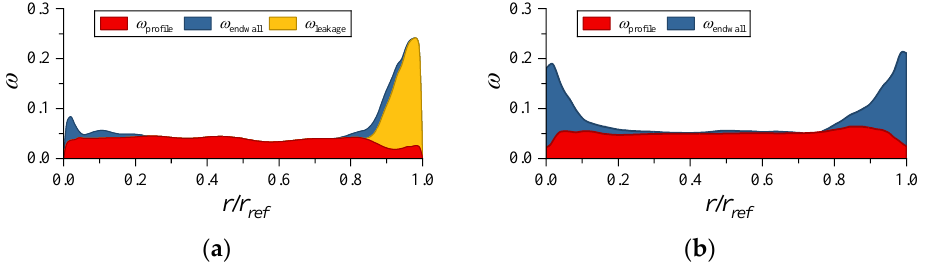
Figure 19. Decomposition of the total pressure loss along the radial direction ( ψ = 0.41, design point): ( a ) rotor; ( b ) stator.